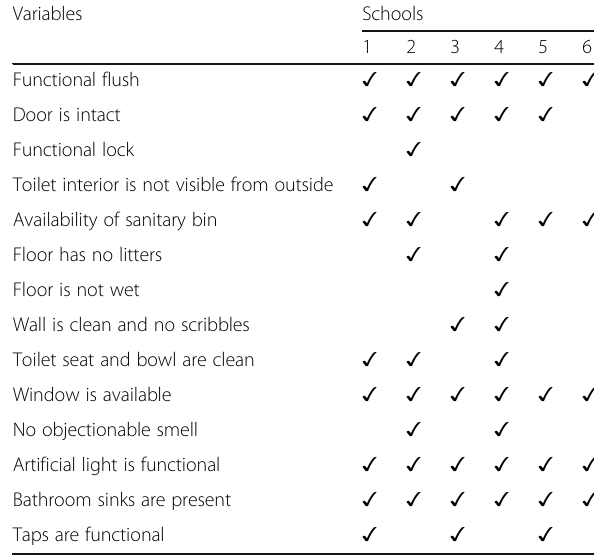
Table 4 Results of toilet